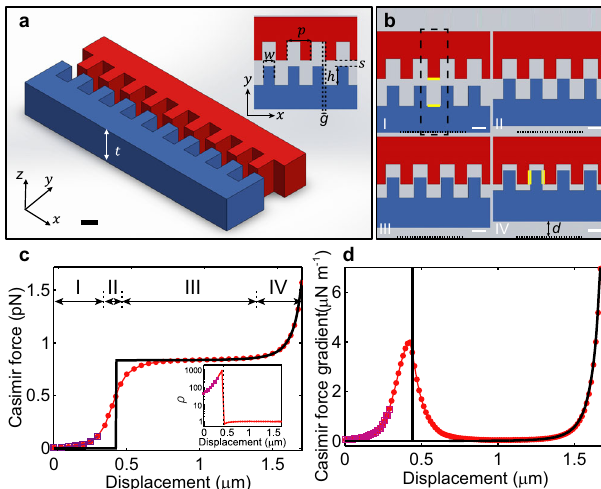
Fig. 1 The Casimir force between perfectly rectangular gratings. a Schematic of a part of the perfectly rectangular silicon grating. Initially, the displacement d of the movable grating (blue) along the y -direction is zero. The inset shows the top-view schematic. h represents the length of a grating fi nger. The lateral separation between adjacent grating fi ngers is g ¼ p = 2 (cid:2) w (cid:3) 92nm and the initial separation in y is s (cid:3) 430nm. b Top- view schematic for the interpenetration of the two gratings. I – IV panels depict the four stages of the interpenetration. The black dotted line denotes the initial location of the bottom edge of the blue movable grating. d is de fi ned as the displacement of the movable grating from this initial position. The dashed frame encloses a unit cell. The bars measure 1 μ m. c Calculated Casimir force per unit cell in the y -direction as a function of displacement d . The black line is the force calculated using the PFA. The red circles and purple squares are the Casimir force calculated by SCUFF-EM and the scattering theory respectively. Inset: The ratio ρ of the Casimir force to the force obtained by the PFA. The black dashed line marks where interpenetration occurs. d The gradient of the Casimir